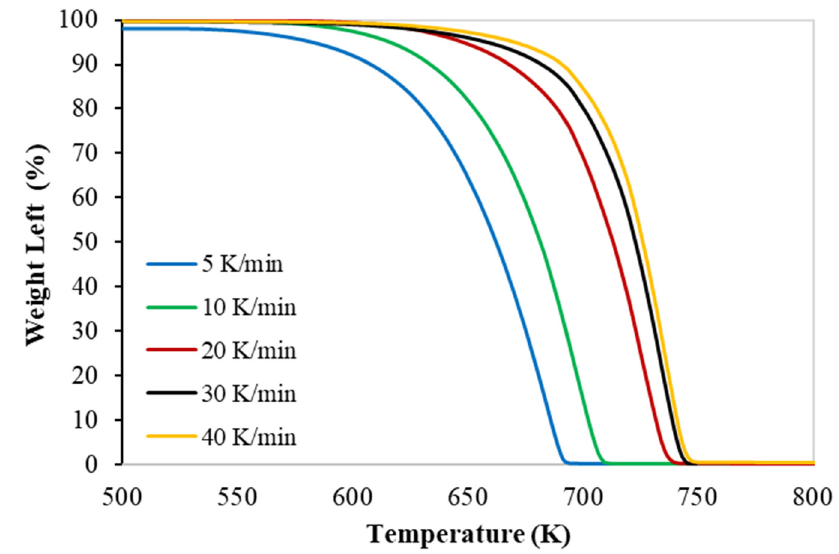
Figure 1. TG curves of PP at different heating rates.